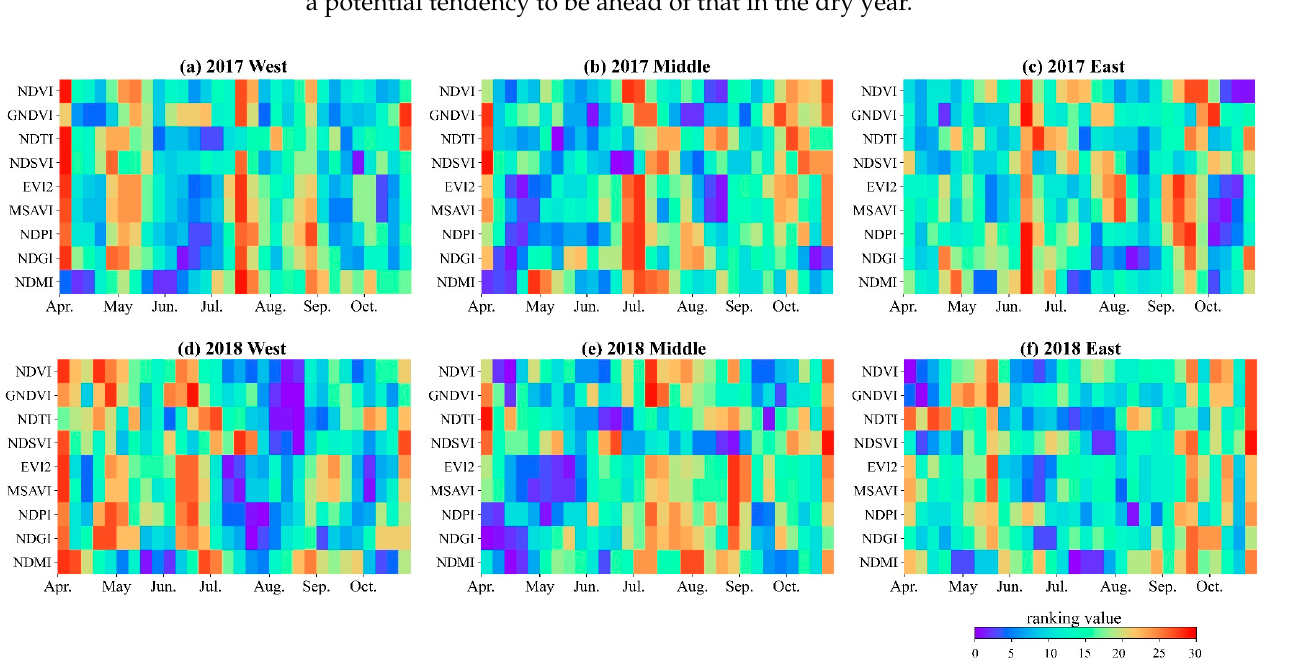
Figure 8. Integrated ranking results of feature importance of RFR and GPR in 2017 ( a – c ) and 2018 ( d – f ). From blue to red, the climbing ranking values indicate the increase in feature importance.